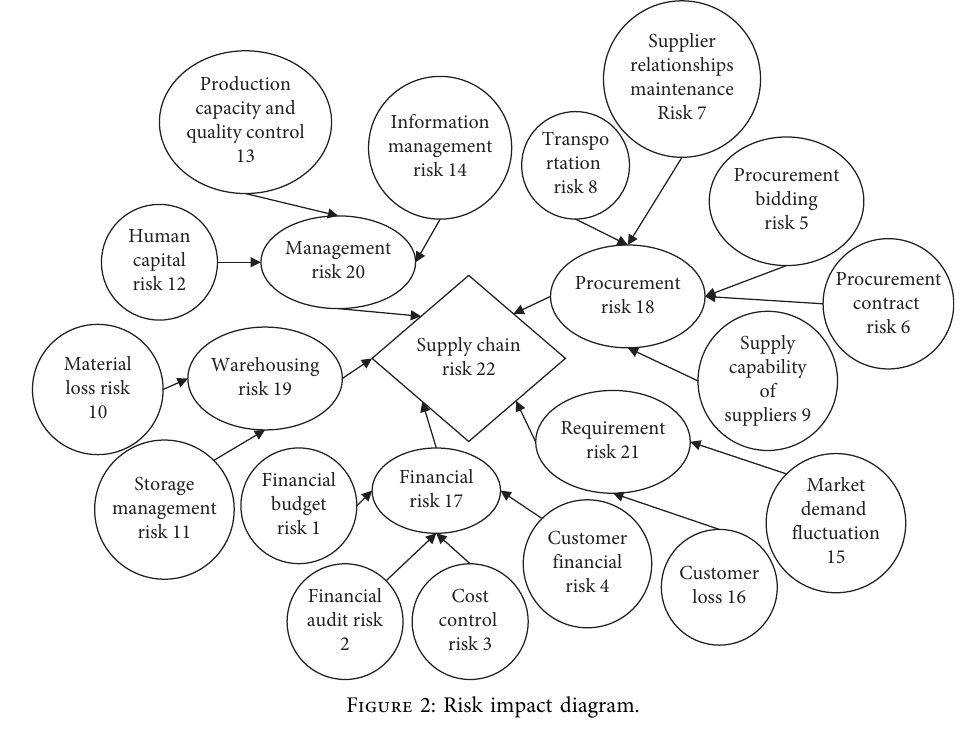
Figure 2: Risk impact